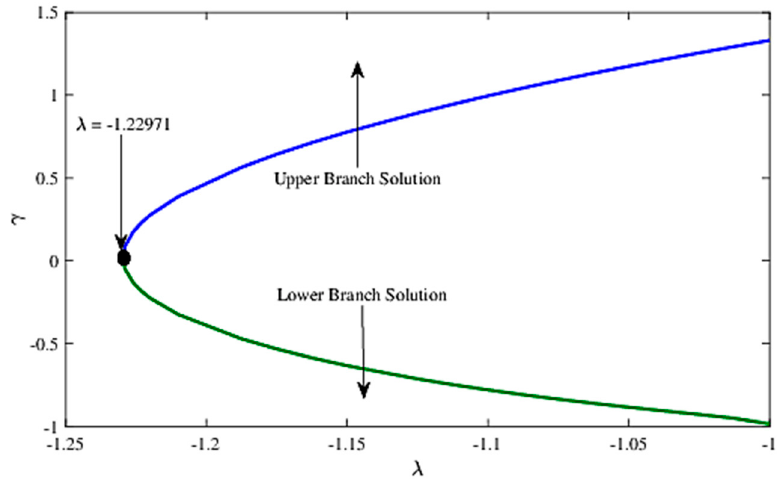
Figure 9. The smallest eigenvalues γ for selected values of λ .